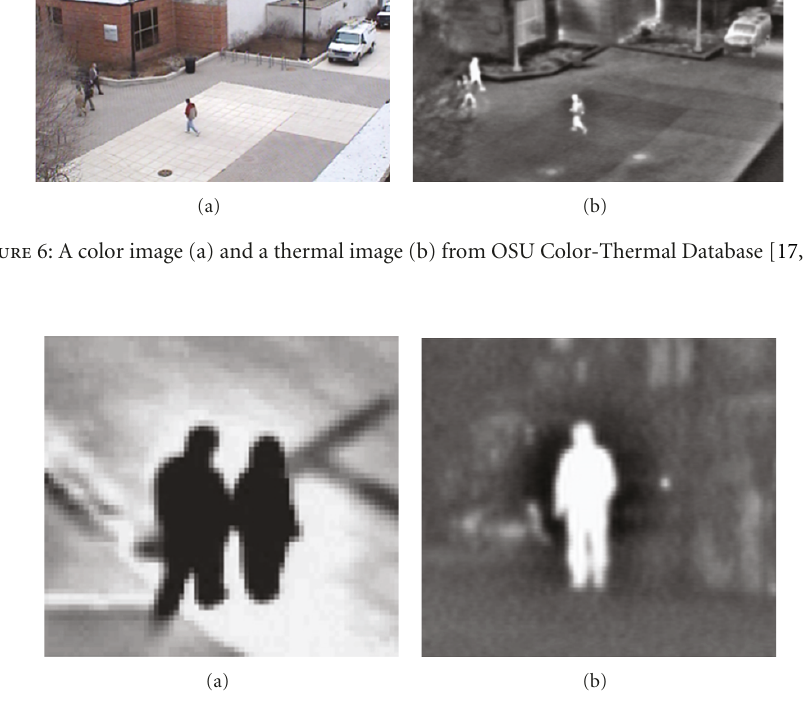
Figure 7: Uncalibrated polarity and halo issues in thermal imagery: (a) bright halo around dark objects [105], (b) dark halo around bright object